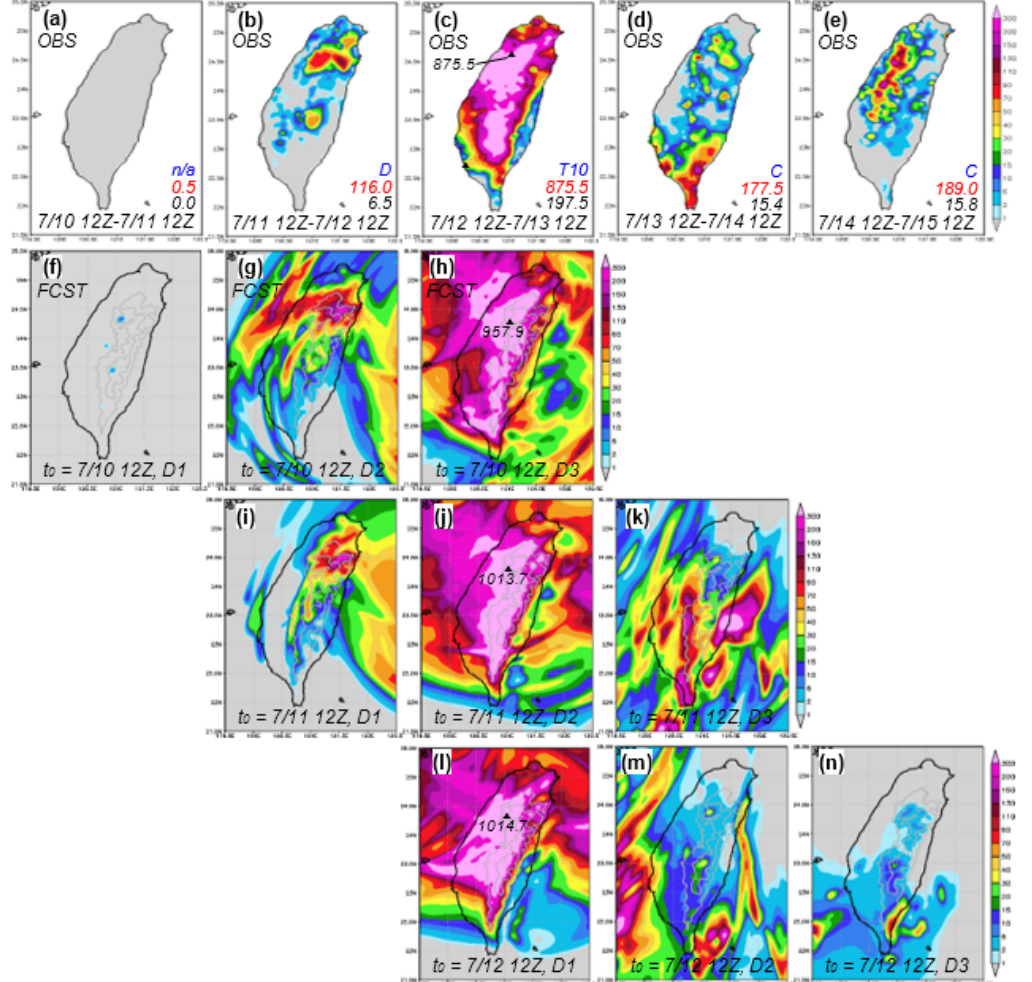
Figure 4. Observed 24 h rainfall distributions (mm, 12:00–1200 p.m. UTC) over Taiwan starting from 12:00 p.m. UTC of ( a ) 10 to ( e ) 14 July 2013, and corresponding CReSS 24 h QPFs made at 12:00 p.m. UTC 10 July for ( f ) day 1 (0–24 h), ( g ) day 2 (24–48 h), and ( h ) day 3 (48–72 h), during TY Soulik. ( i – k ) and ( l – n ) As in ( f – h ), but showing day 1 to day 3 QPFs made at 12:00 p.m. UTC 11 and 12 July 2013, respectively. The classification group (see text for details) and observed maximum and averaged amounts are given in the lower right corner in ( a – e ) and are also marked in ( c ). The color scales are identical for all panels.